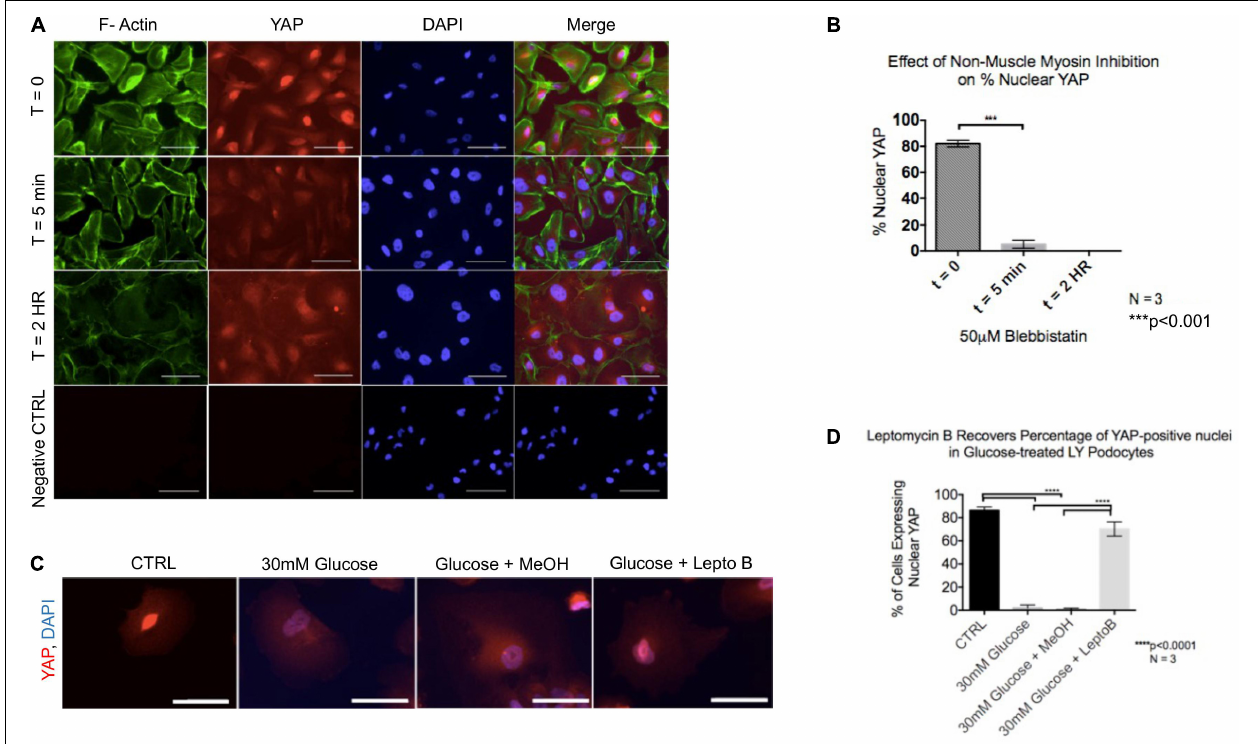
FIGURE 5 | YAP translocation precedes cytoskeletal rearrangement during podocyte stress response (A) Immunofluorescence staining demonstrates F-Actin (green) and YAP (red) localization in podocytes treated with non-muscle myosin inhibitor, Blebbistatin. DAPI (blue) detects nuclei. (B) Quantification of percentage of nuclear YAP positive cells following Blebbistatin treatment. 100 cells per timepoint per experiment were assessed for YAP localization, N = 3. *** p < 0.001, one-way ANOVA, multiple comparisons test, data presented as mean ± SD. (C) Immunofluorescence staining demonstrates YAP (red) and DAPI (blue) staining in podocytes treated with glucose, glucose + vehicle, and glucose + Leptomycin B. Magnification, 40 × . Scale bar = 50 µ m. (D) Quantification of cells expressing nuclear YAP in immunofluorescence images of all conditions. One way ANOVA, multiple comparisons test, data presented as mean ± SD, **** p < 0.0001, and N =